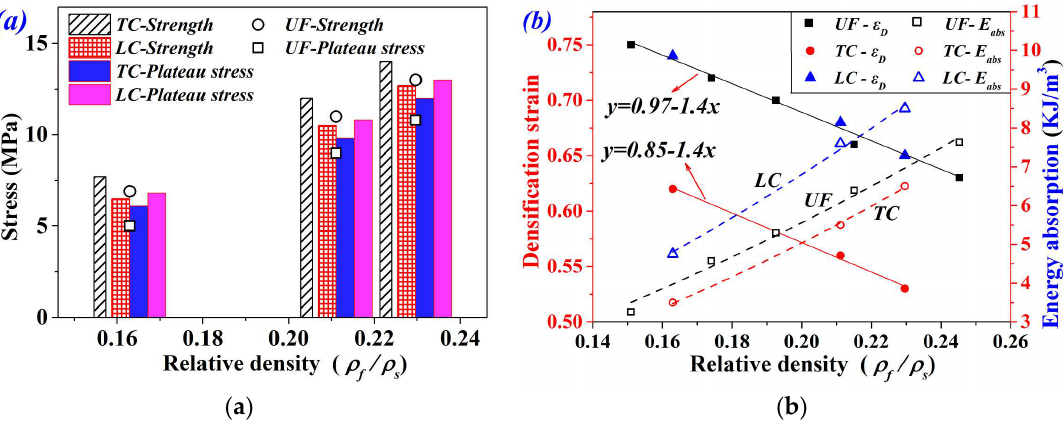
Figure 8. ( a ) Mechanical properties and ( b ) energy absorption of UF and FG foams.